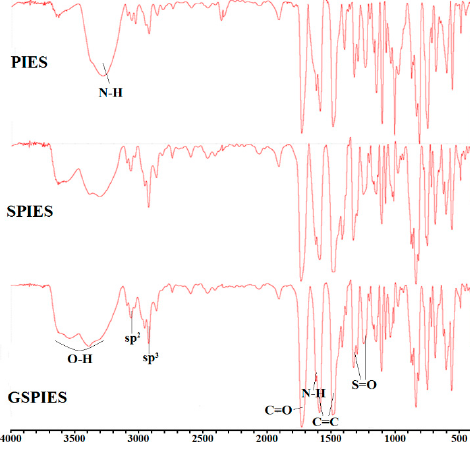
Figure 4. FT-IR of PIES, SPIES and GSPIES.